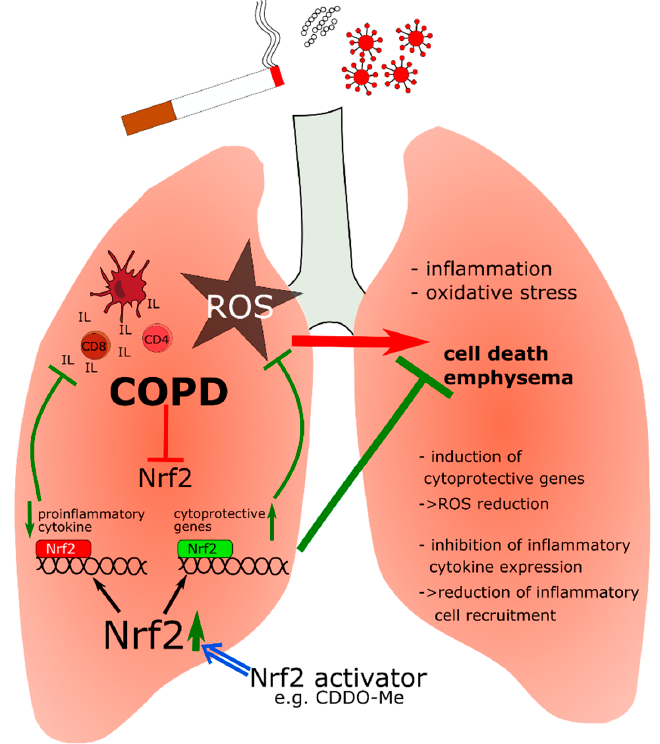
Figure 4. Influence of Nrf2 activation on COPD. Air pollutants, cigarette smoke and bacterial or viral infection cause oxidative stress and inflammation in the lung. Nrf2 activation induces cytoprotective gene expression to counteract the toxic effect of ROS. Moreover, Nrf2 inhibits transcription of proinflammatory cytokines, especially in macrophages, to reduce the recruitment of inflammatory cells into the lung. If Nrf2 is reduced, inflammation and ROS lead to cell death of lung epithelial cells and consequently mediate emphysema. CD4/CD8—effector/cytotoxic T-cells; IL—interleukins; —NF-E2 p45-related factor 2; ROS—reactive oxygen species, ↑ / ↓ = up-/downregulation of expression with a positive effect on disease progression, T-bars/T-bars = inhibition with a positive/negative effect on disease